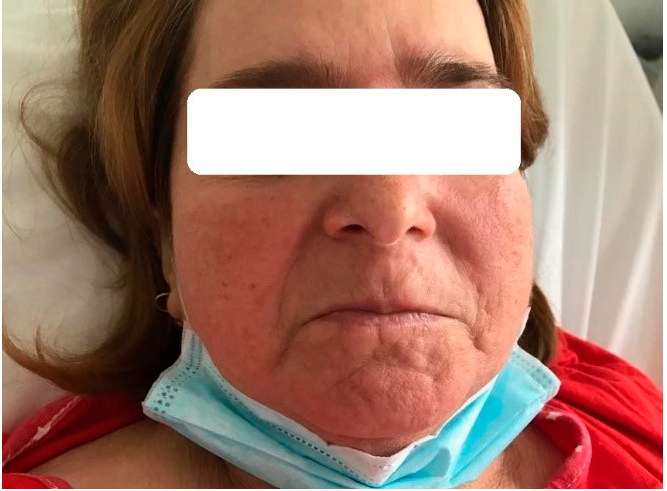
Figure 3. Urticarial-like exanthema (case 3).